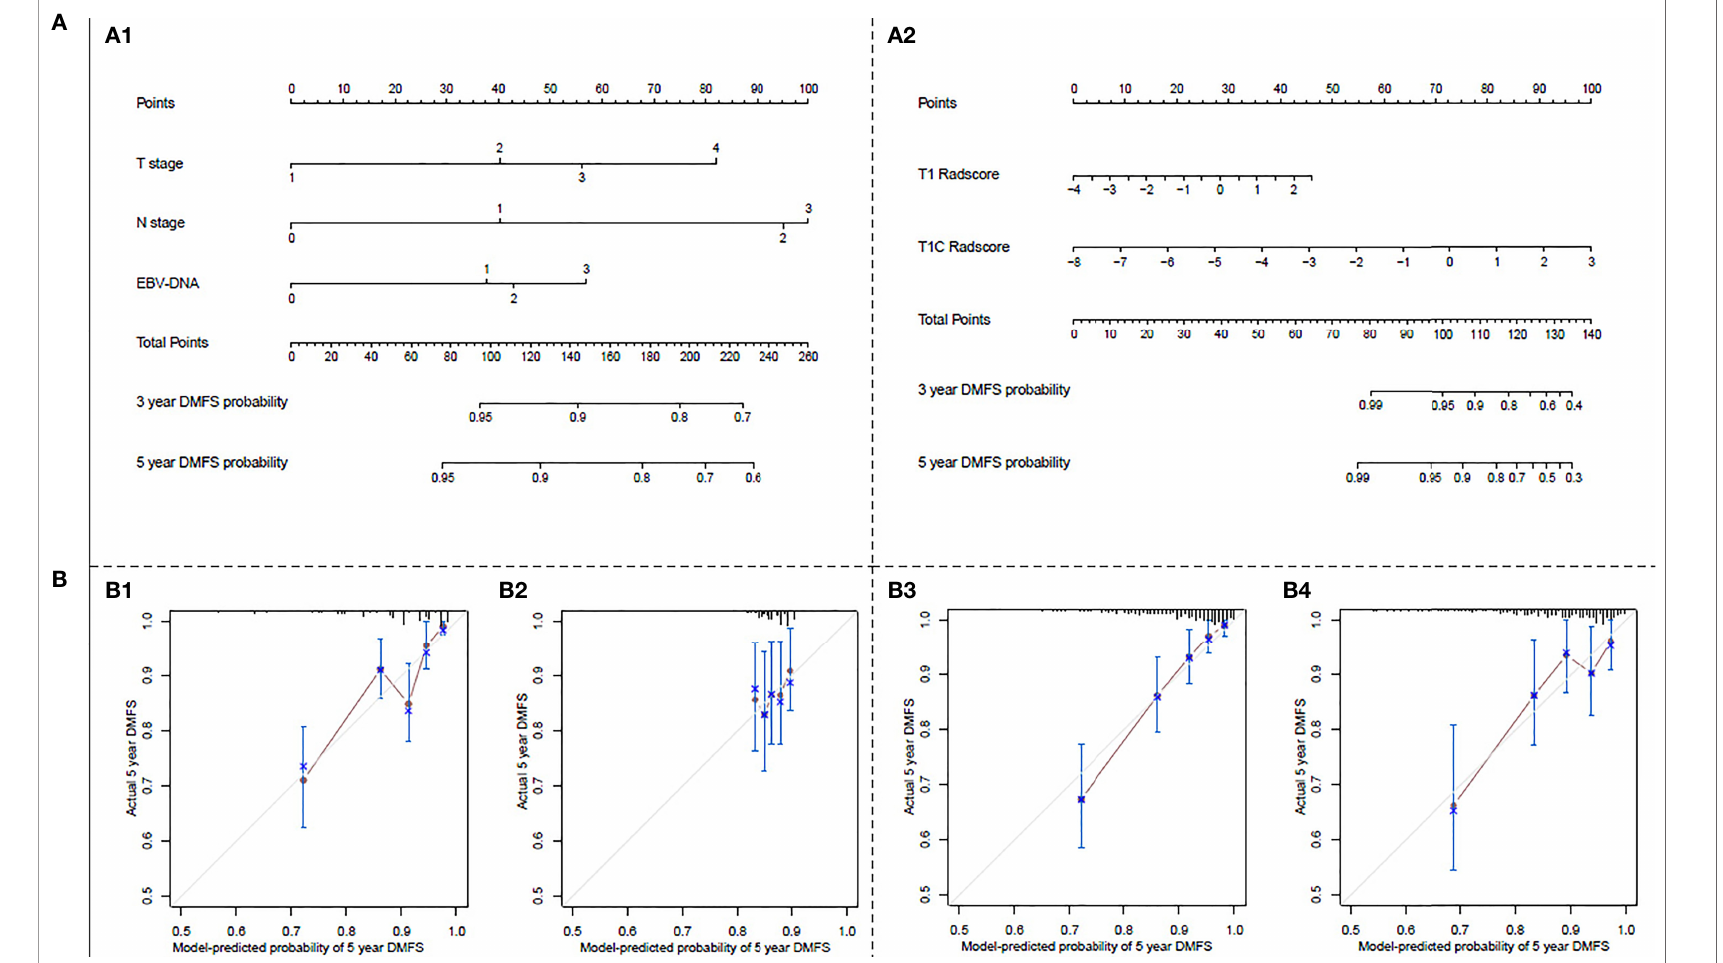
FIGURE 1 | (A) Nomograms for 3- and 5-year distant metastasis-free survival (DMFS): (A1) for the clinical prognostic model, (A2) for the T1+T1C prognostic model. The nomogram allows the user to obtain the probability of 3- and 5-year DMFS corresponding to a patient combination of covariates. As an example, locate the patient T stage and draw a line straight upward to the “ Points ” axis to determine the score associated with that T stage. Repeat the process for each variable and sum of the scores achieved for each covariate; after that, locate this sum on the “ Total Points ” axis. Draw a line straight down to determine the likelihood of 3- or 5-year DMFS. (B) Calibration curves for predicting 5-year DMFS: (B1) in the primary cohort of the clinical prognostic model, (B2) in the validation cohort of the clinical prognostic model, (B3) in the primary cohort of T1+T1C prognostic model, (B4) in the validation cohort of T1+T1C prognostic model. The Y-axis shows observed survival estimated by the Kaplan – Meier method, and the X-axis shows predicted survival calculated using the prognostic model. The solid lines represent the ideal reference line for which predicted survival corresponds with actual